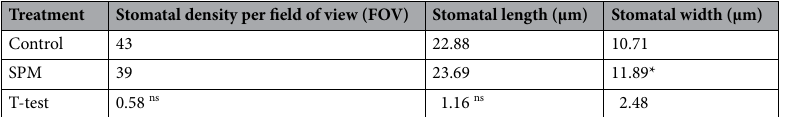
Table 11. Effect of SPM on stomatal density, length and breadth of MR219 in KADA during off season. T-test was performed at P ≤ 0.05. *: Significant at P ≤ 0.05.